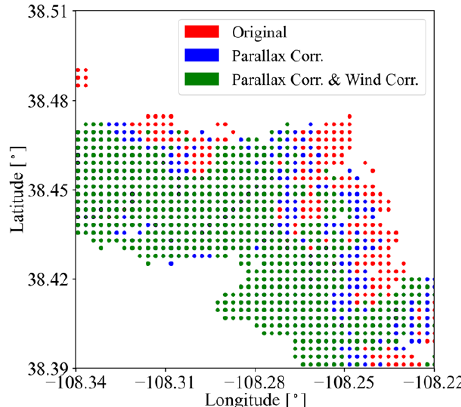
Figure D1. An illustration of correcting cloud location (red) for par- allax effect (blue) and wind effect (green) for the cloud field of the inset in Fig. 2. Filled cloud gaps are as described in Appendix D1 are indicated by black